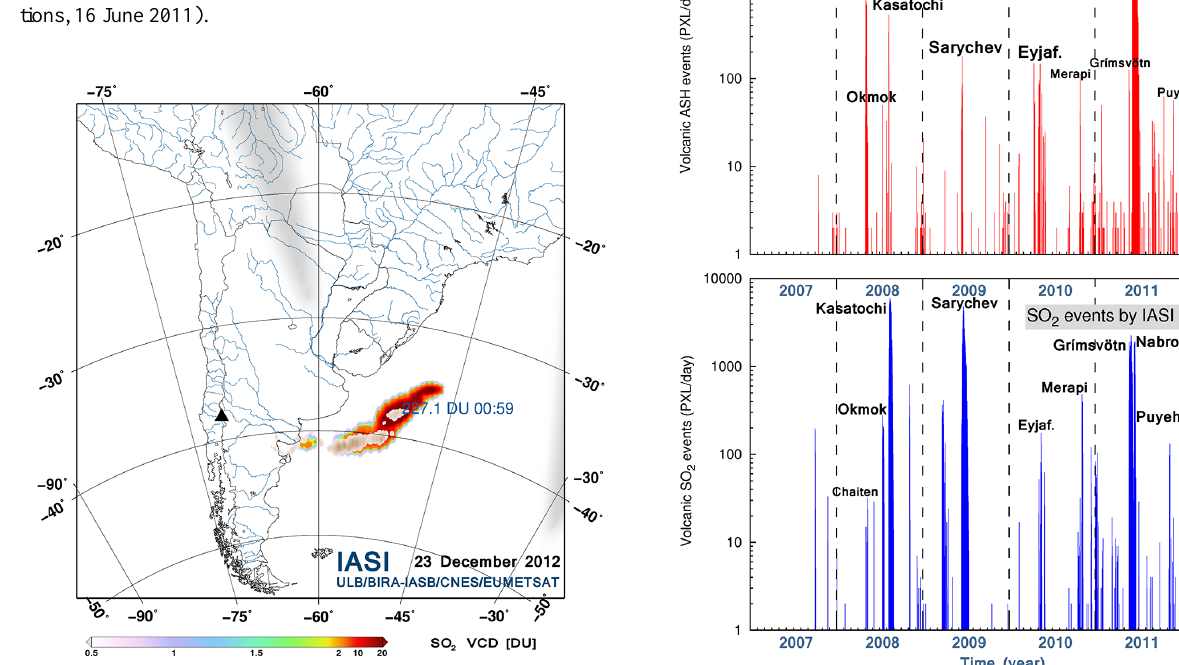
Fig. 23. SO 2 and ash detected by IASI-A (Nabro and Puyehue erup- tions, 16 June 2011).